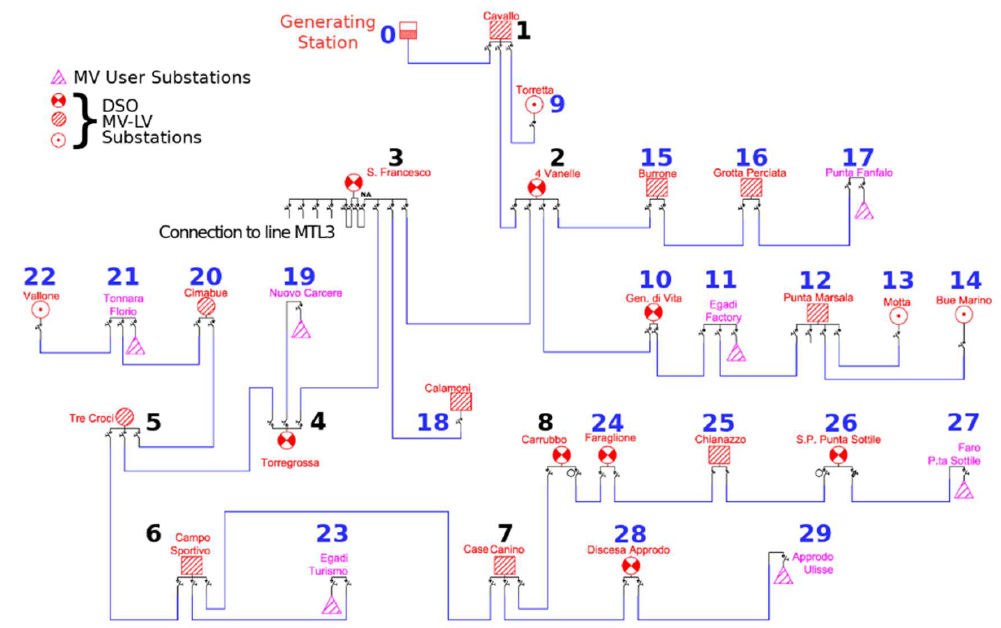
Figure 5. Electrical scheme of the feeder “MT L1” of the Favignana MV distribution network.